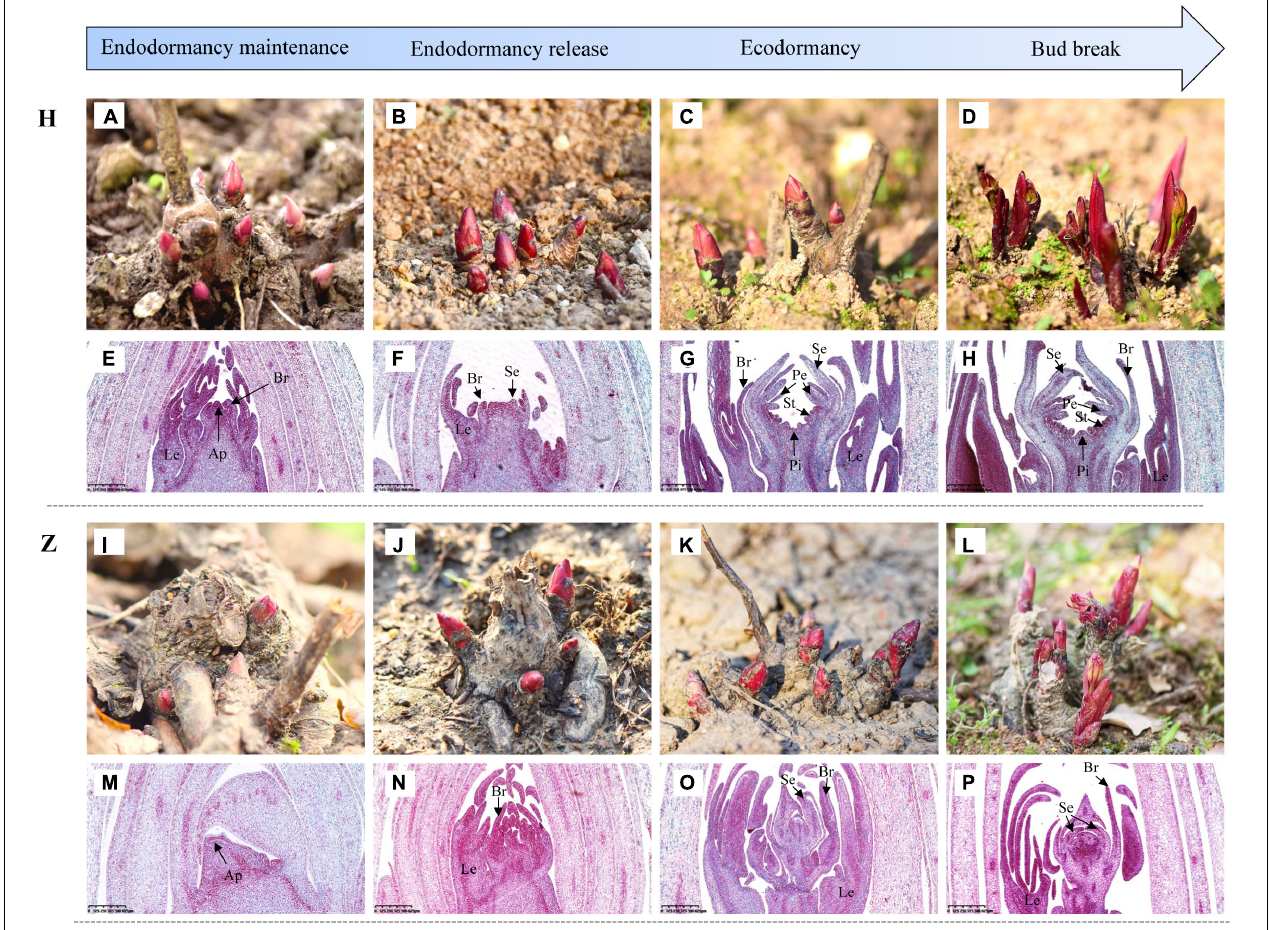
FIGURE 3 | Observations of developmental growth stages and bud differentiation in P. lactiflora . (A–D) Developmental growth stages from bud endodormancy maintenance to bud break of buds in low CR ‘Hang Baishao.’ (E–H) Bud differentiation of buds in low CR ‘Hang Baishao.’ Le, Leaf primordia; Br, Bract primordia; Se, Sepal primordia; Pe, Petal primordia; St, Stamen primordia; Pi, Pistil primordia; and Ap, Apical meristem (Scale bar: 625 µ m). (I–L) Developmental growth stages from bud endodormancy maintenance to bud break of buds in high-CR ‘Zhuguang.’ (M–P) Bud differentiation of buds in high-CR ‘Zhuguang’ (scale bar: 625 µ m). H represents ‘Hang Baishao’; Z represents